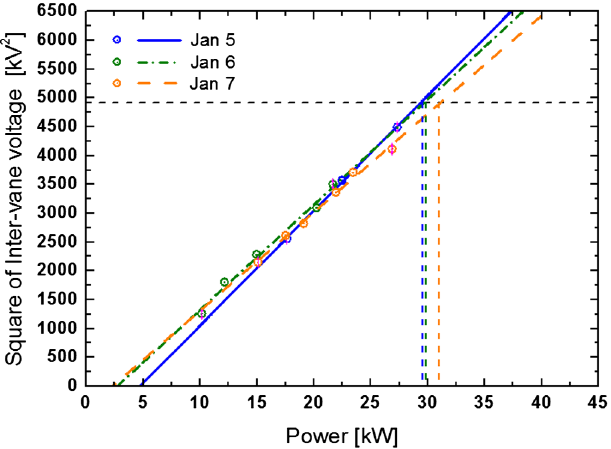
FIG. 23. The calculated inter-vane voltage as a function of rf input power.